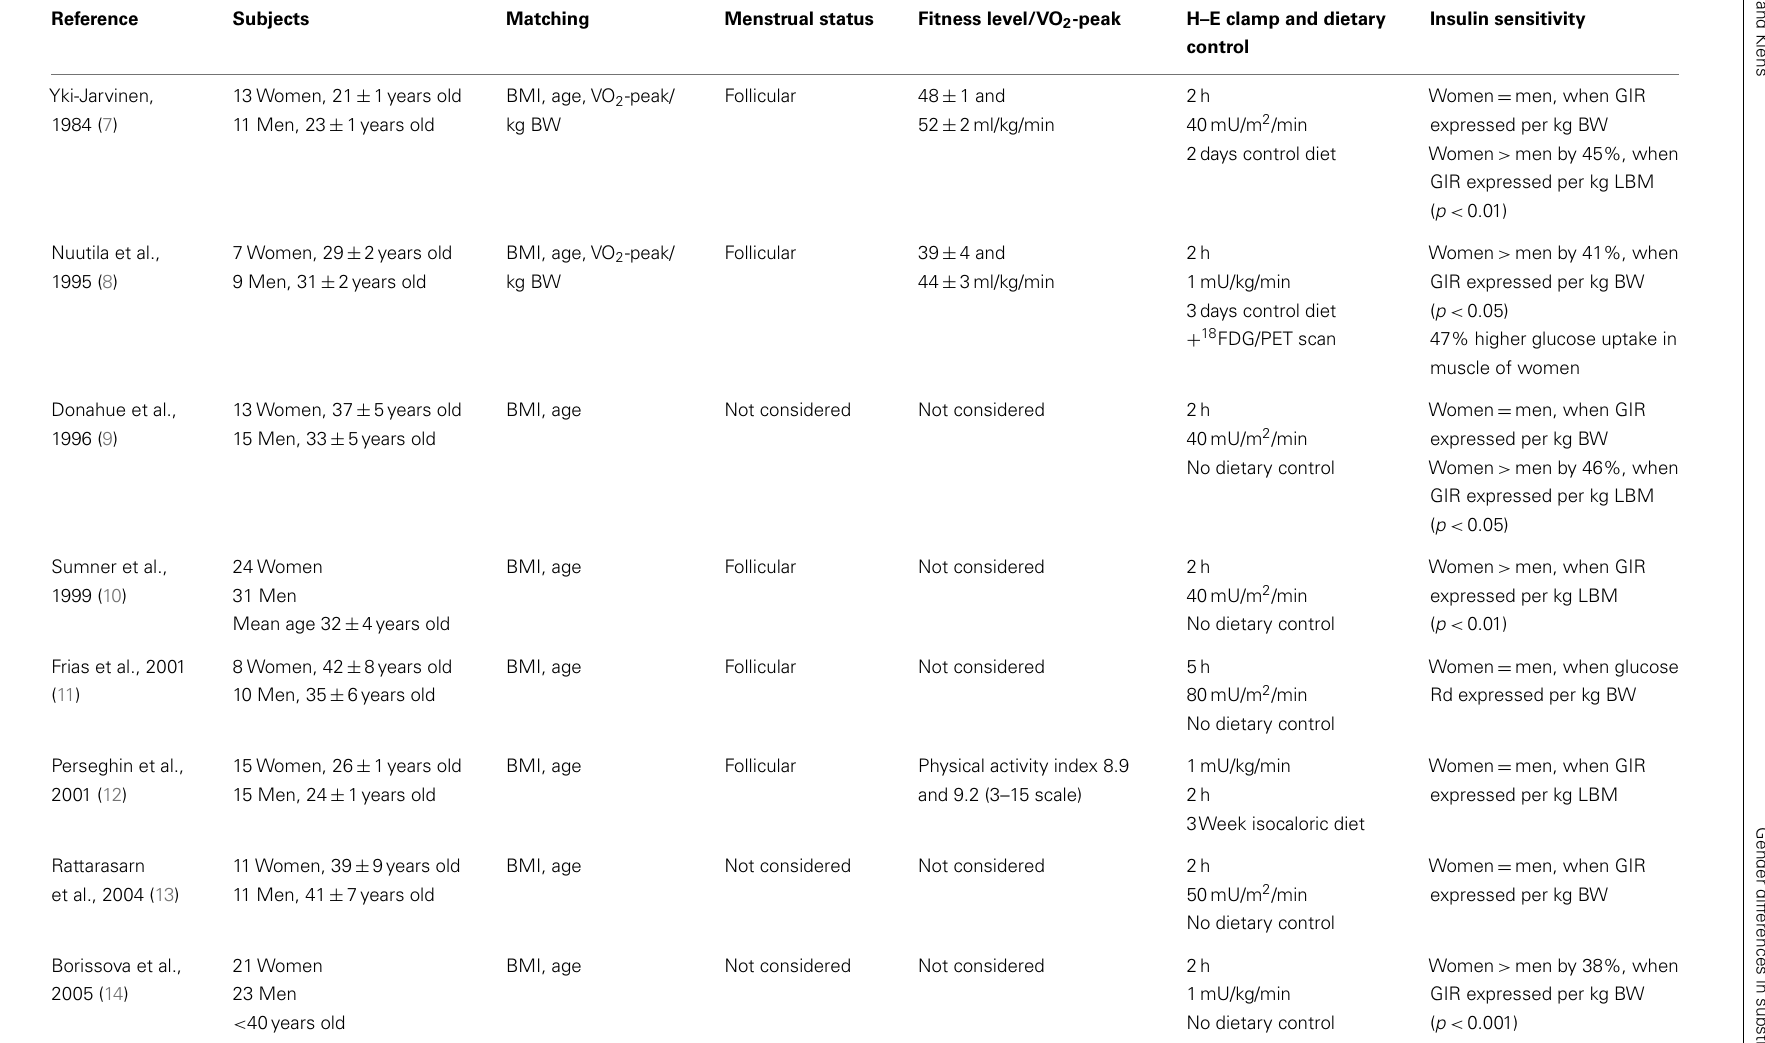
Table 1 | Summary of H–E clamp studies in healthy premenopausal women and men